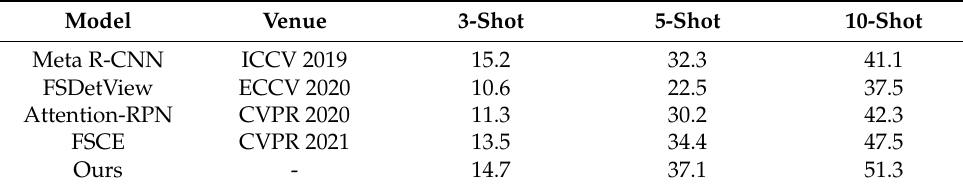
Table 1. Comparison of precision @50 of aircraft in satellite videos (%).